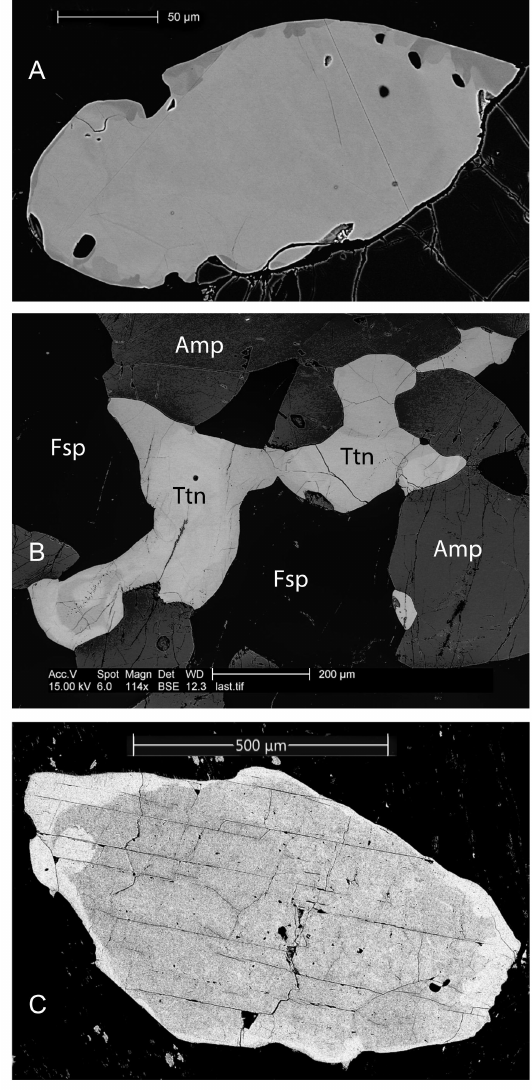
Figure 24. BSE images of some titanite grains from metamorphic rocks. ( A ) Subhedral titanite grain with dark REE-poor rim from a banded Precambrian granitic gneiss, Herschel Township, Hastings County, Ontario. ( B ) Titanite (Ttn—light gray) between grains of amphibole (Amp—medium gray) and feldspar (Fsp—dark gray) in a Precambrian gneiss, north of Lake Clear, Renfrew County, Ontario. ( C ) Subhedral titanite with bright REE-enriched rim from biotite schist in the Precambrian Santaquin Complex near Santaquin,